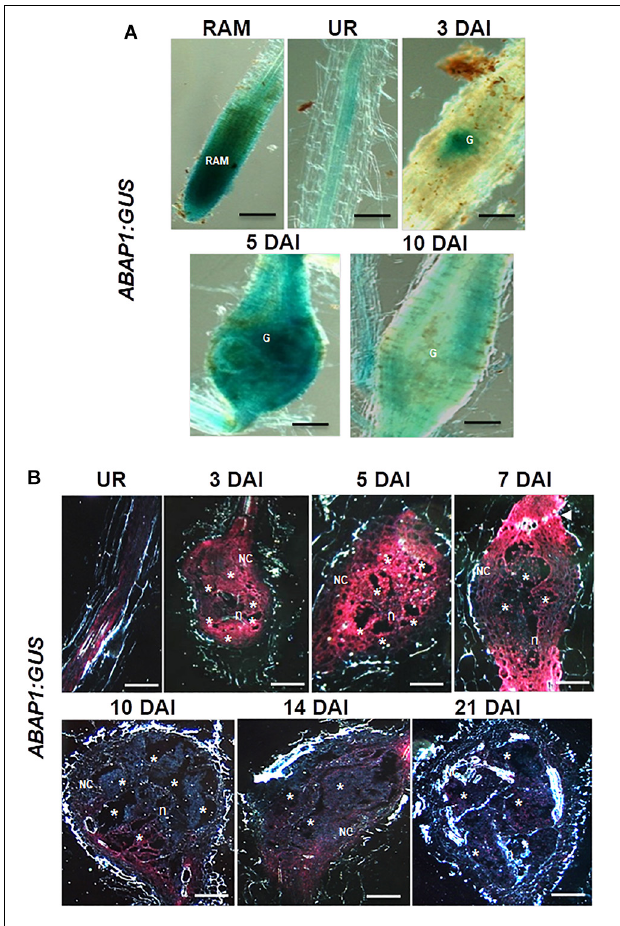
FIGURE 3 | ABAP1 localization in M. incognita -induced galls. (A) Immunofluorescence of ABAP1 (green) in wild-type and ABAP1 OE galls 5 DAI and 10 DAI. (B) Images show galls 5 and 10 DAI treated with the normal serum (NS). DAPI-stained nuclei are visualized in red. Asterisk, giant cell; n, nematode, NC, neighboring cells. Scale bars = 50 µ